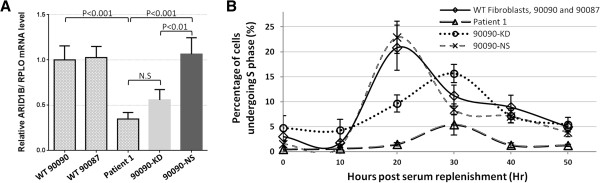
ARID1B haploinsufficiency results in delayed S1 Phase entry. Real Time Quantitative PCR analysis of patient-derived (Patient 1) and control (90087 and 90090) fibroblasts was performed using Taqman probes directed against ARID1B and the housekeeping control RPLO. Samples were normalised to control 90090, which was assigned a value of 1 and analysed by the Pfaffl relative quantification method. The expression of ARID1B was significantly reduced in both Patient 1 and the control 90090 after shRNAmir mediated knockdown of ARID1B (90090-KD), whereas the non-silencing control did not alter ARID1B expression (90090-NS) (A). Cell cycle dynamics of serum-starved cells undergoing S1 phase after serum replenishment was analysed using ModFit LT. The percentage of cells undergoing S1 phase at 20 hours post serum replenishment was significantly lower in both patient 1 (P = 0.0002) and 90090-KD (P = 0.005) compared to control (B).